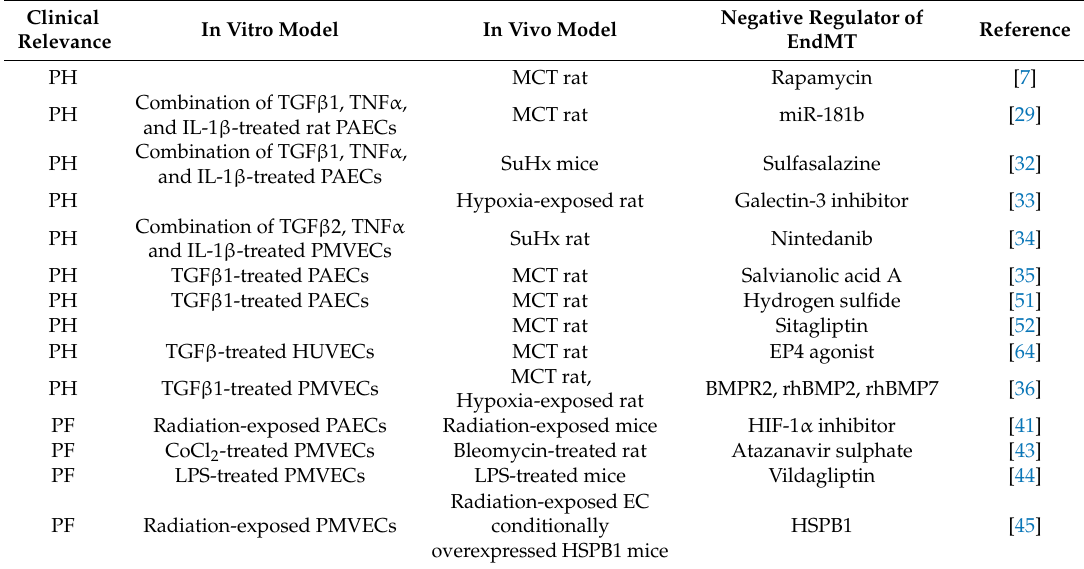
Table 2. Key studies targeting EndMT as a therapeutic strategy in PH and